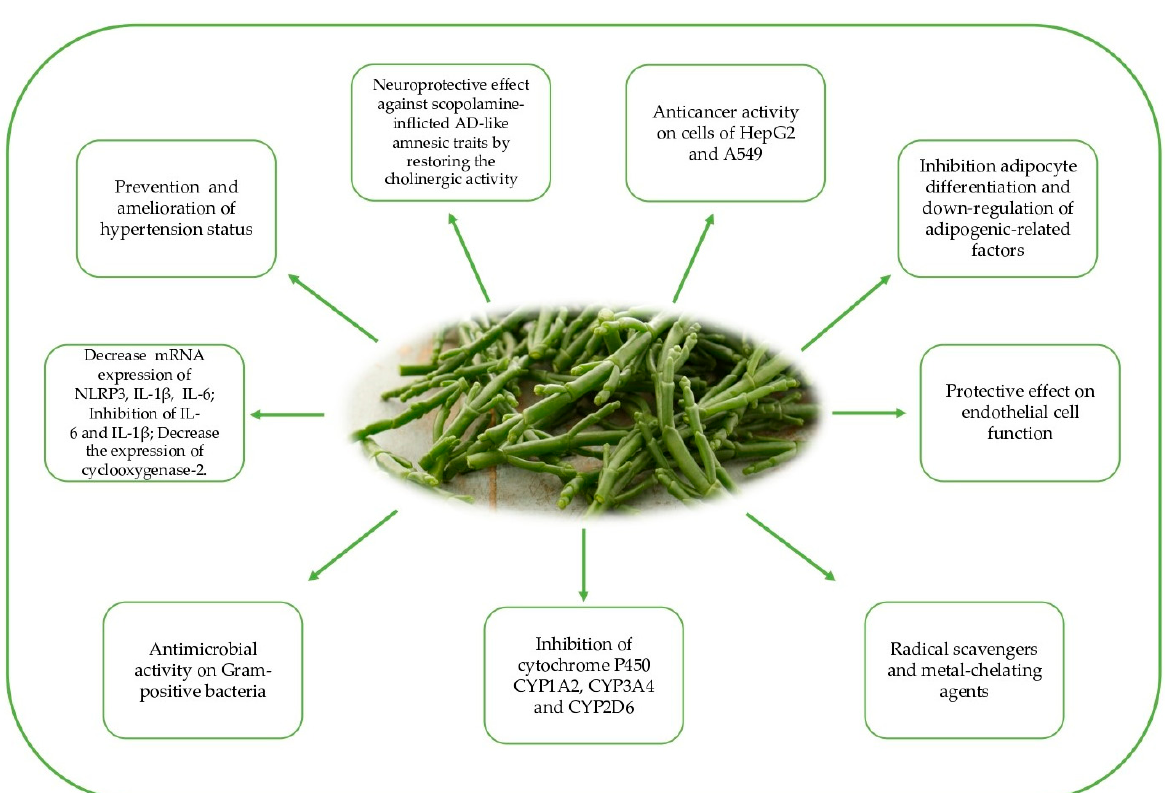
Figure 1. Health biological effects of Salicornia.